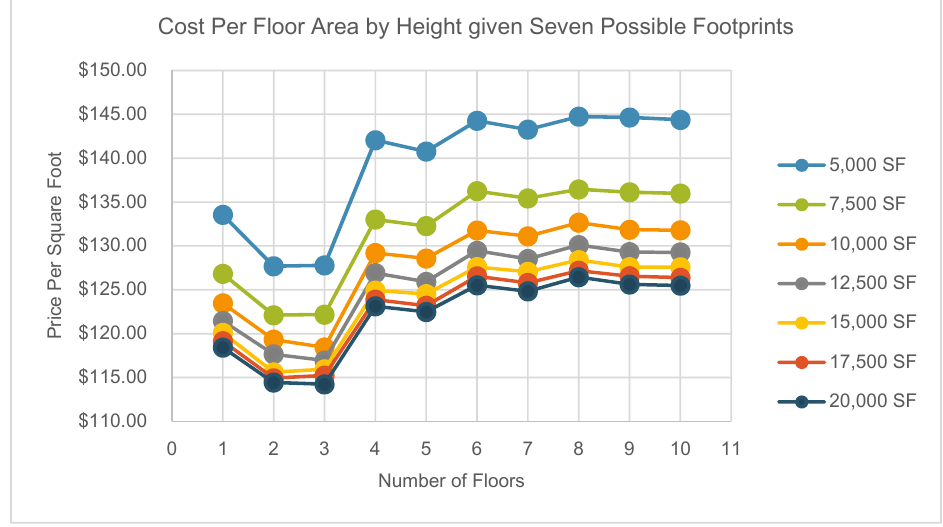
Figure 9. Cost per Unit Floor Area given a Static Footprint and Variable Total Building Area.